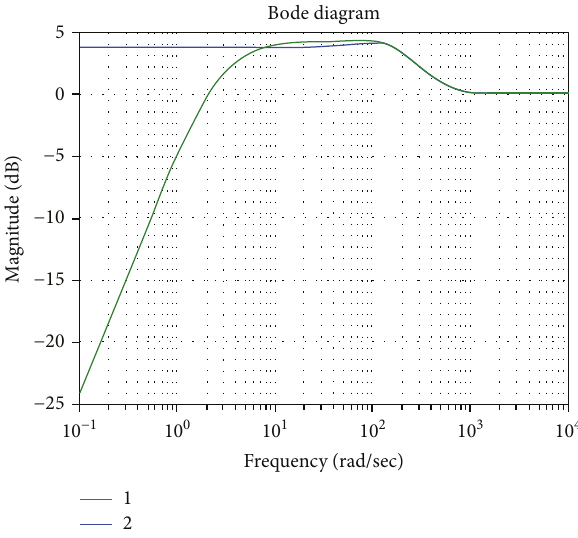
Figure 14: Sensitivity function with integral